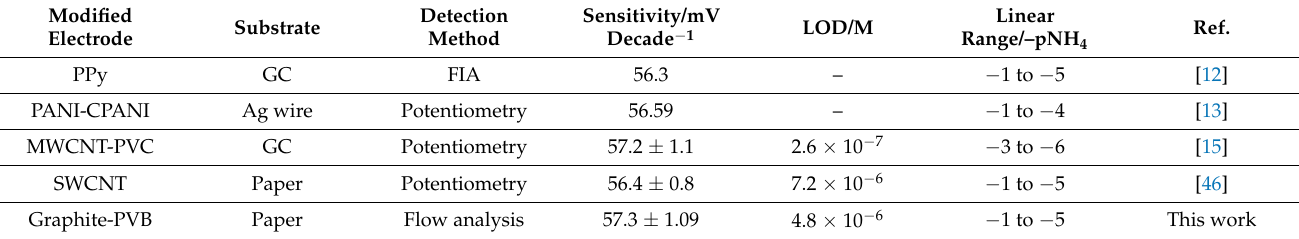
Table 3. Comparison of various nonactin-based potentiometric sensors for selective determination of NH 4 . Modified